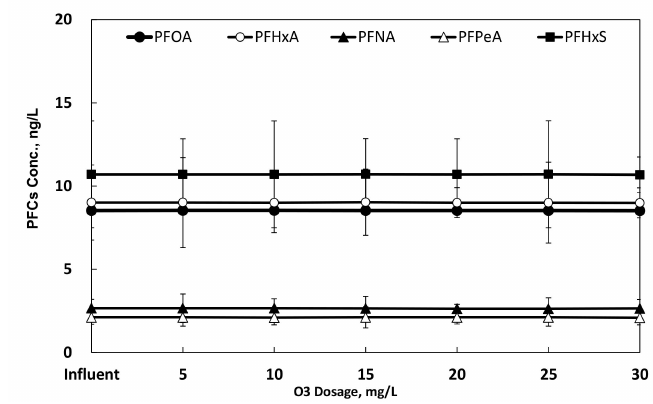
Figure 4. Variations of PFCs concentration by O 3 dosages.